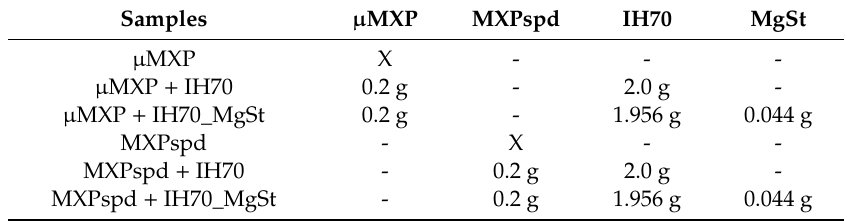
Table 1. The composition of the prepared dry powder inhalation (DPI) samples.